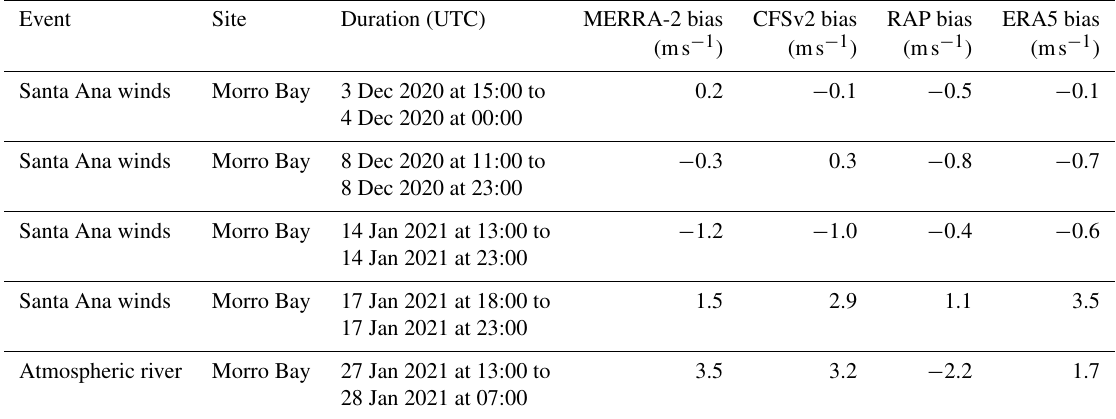
Table 3. Model bias during Pacific coast weather events during the lidar buoy deployments.